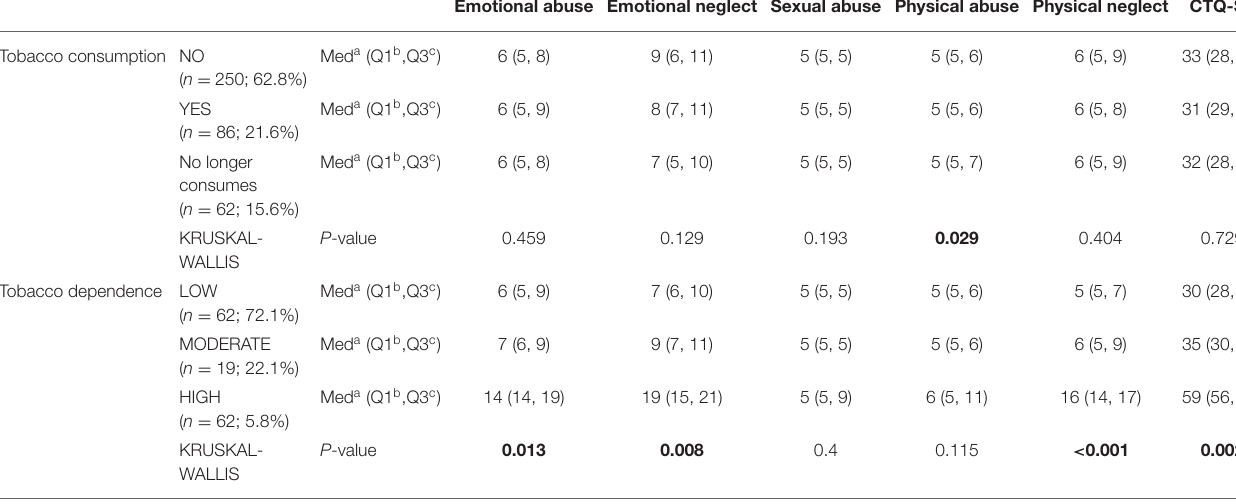
TABLE 3 | Median, interquartile range, and p -value for the relationship between the different ACE factors and tobacco consumption. Emotional abuse Emotional neglect Sexual abuse Physical abuse Physical neglect